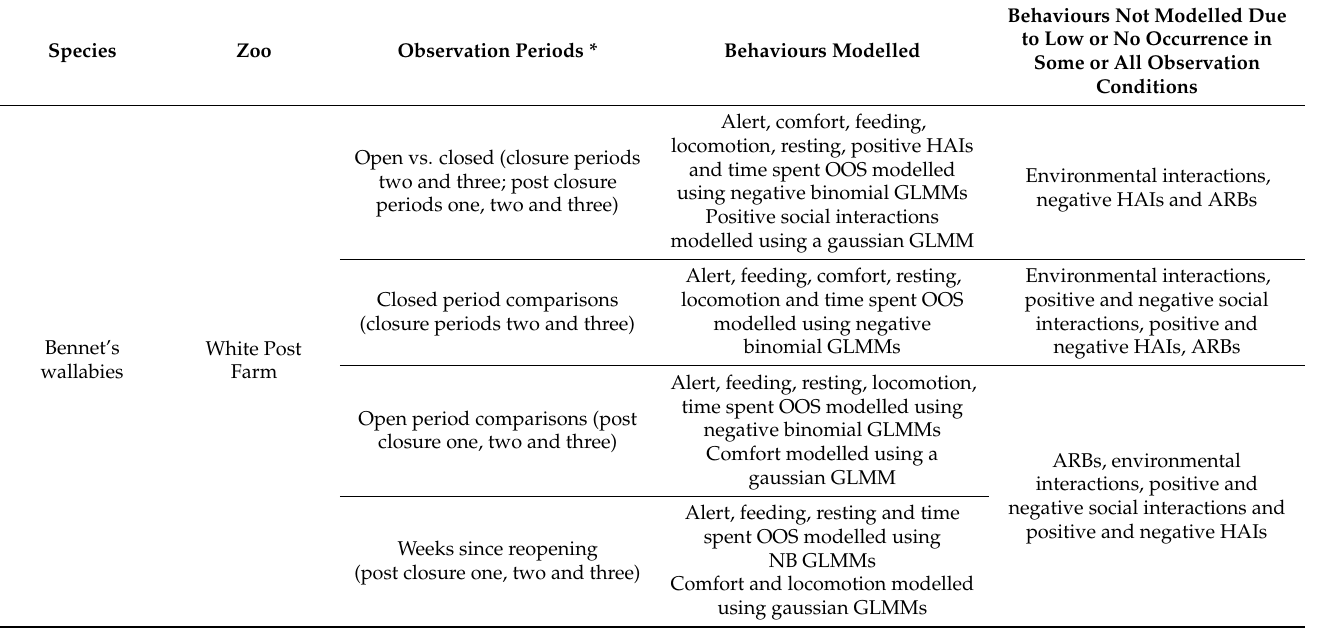
Behaviours Not Modelled Due to Low or No Occurrence in Some or All Observation Conditions